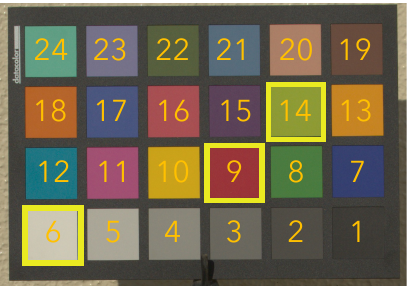
Figure 5. Example of the selected three colors, which are highlighted by yellow squares. Each patch is numbered from 1 to 24, and patches indexed by 6 (white), 9 (red), and 14 (yellow green) were